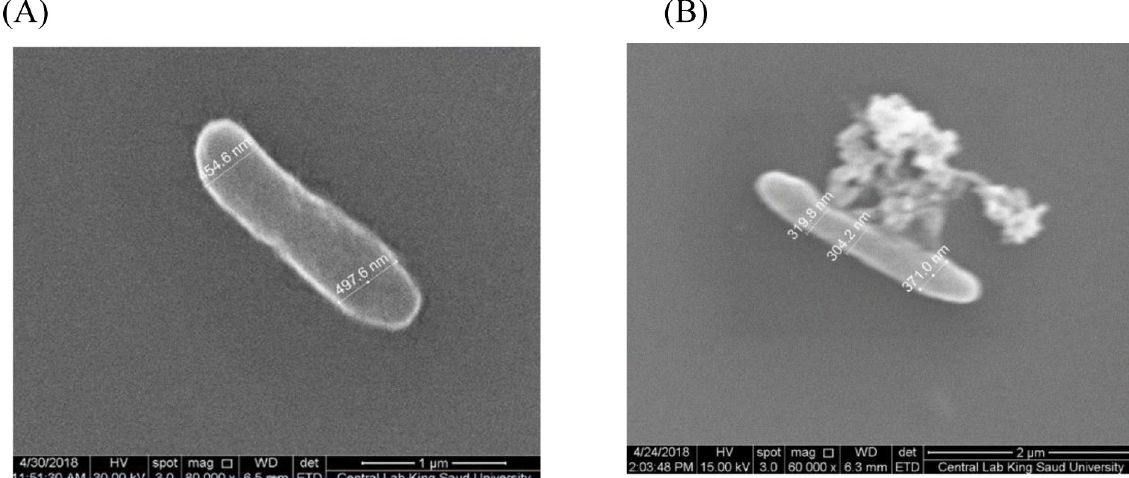
Fig 6. Morphological study of (A) untreated and (B) treated Escherichia coli by (IONPs) using SEM.